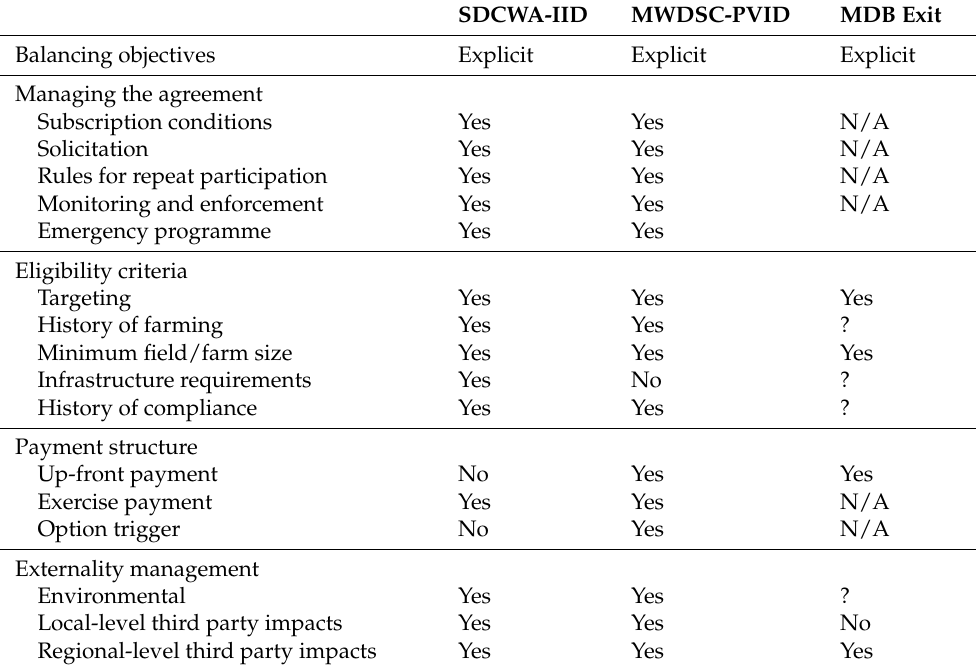
Table 1. Key features for incentive